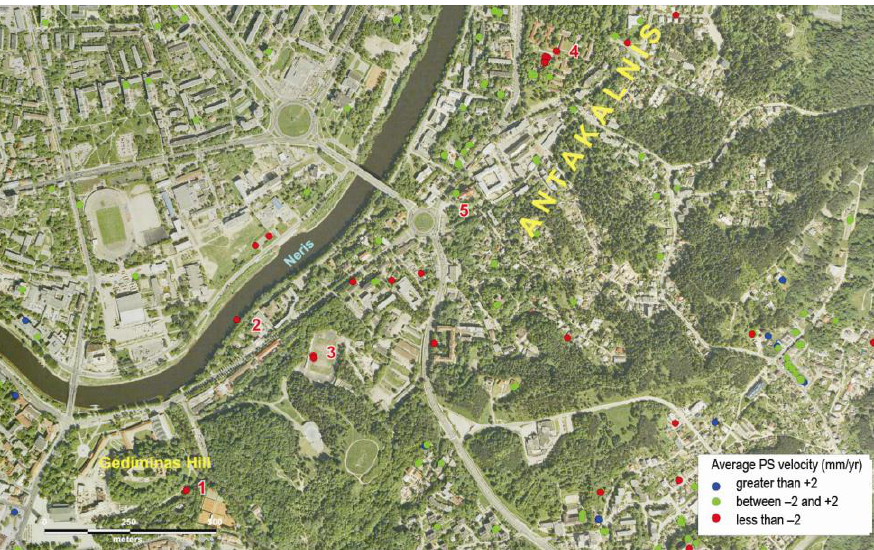
Fig. 4. Location of PS with negative velocities below – 2 mm/yr (red dots), PS with velocities ex- ceeding +2 mm/yr (blue), stable points between – 2 mm/yr and +2 mm/yr (green) in the downtown of Vilnius and the Antakalnis area. Gediminas Hill is in the lower left corner of the image (red dot with number 1). Others PS points with negative values are: point 2 (vicinity of the former Słuszków Palace, at the bank of Neris River and within the alluvial deposits area), point 3 (sport stadium, lo- cated near the hills of Antakalnis), point 4 (former Sapieha Palace, built in 1691) and point 5